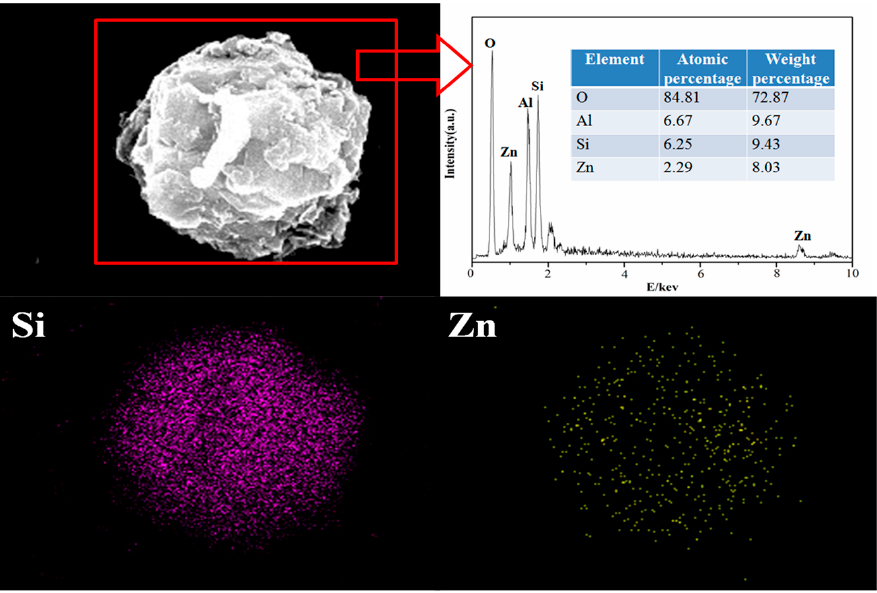
Figure 13. SEM images and EDS analysis of X zeolite adsorbed with Zn 2+ . Table 10. The composition of X zeolite and samples of X zeolite after adsorption with Cu 2+ or Zn 2+ .